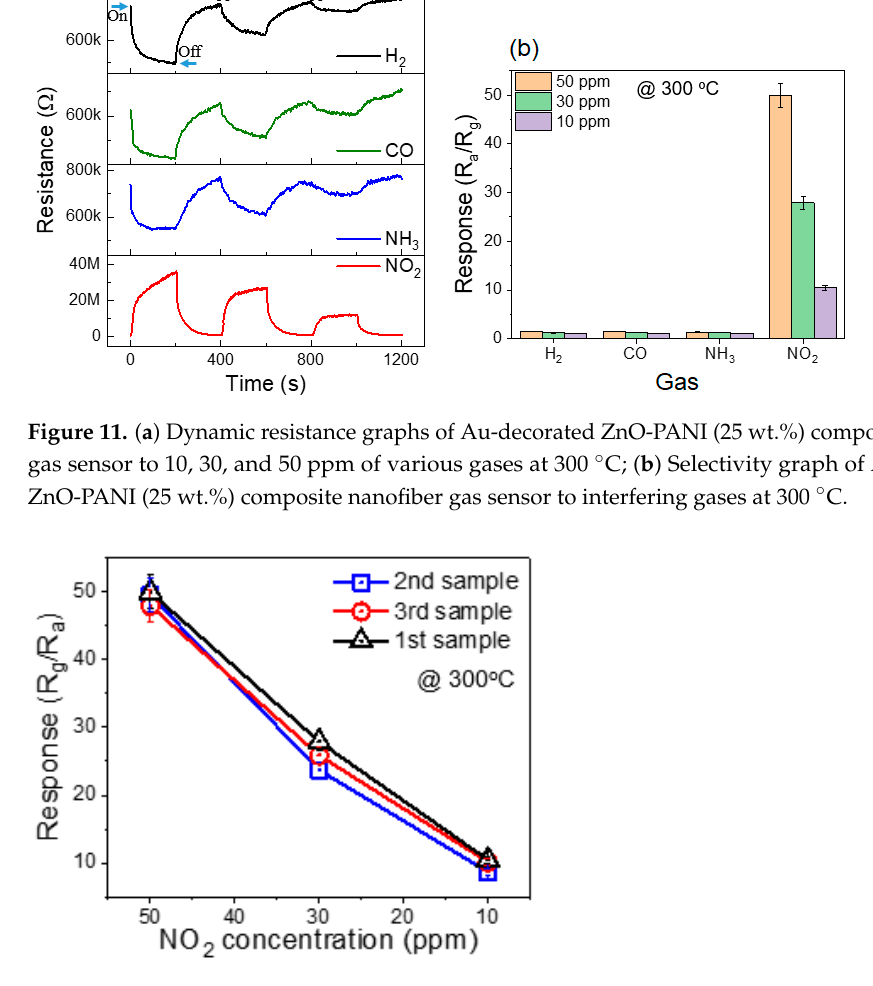
Figure 12. Reproducibility of optimized gas sensor.